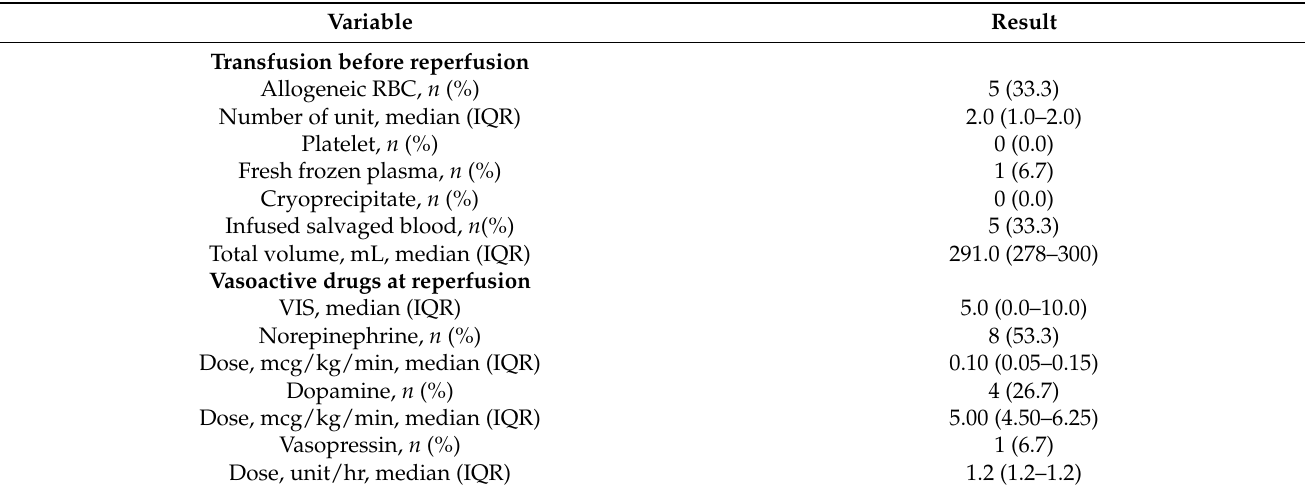
Peak blood potassium after reperfusion showed strong correlations with preoperative blood potassium (Pearson’s r = 0.7, p < 0.004) and blood potassium at T -10 (Pearson’s r = 0.97, p < 0.001) and T 0 (Pearson’s r = 0.95, p < 0.0001). Other perioperative variables did not show a significant correlation with peak blood potassium (Table 3). Hemodynamic parameters and laboratory values measured one hour after the anhepatic phase and at T -10 are presented in Supplementary Table S1. They did not show a significant relationship with peak blood potassium. Changes in the partial pressure of arterial carbon dioxide (PaCO 2 ), pH, bicarbonate, and lactate after reperfusion are presented in Figure 2. After reperfusion, PaCO 2 increased, and pH decreased significantly, and those values did not return to baseline after 5 min. Lactate increased until T 3 and then returned to baseline at T 4 . After reperfusion, mean arterial blood pressure started to decrease at T 2 and returned to its baseline at T 4 (Supplementary Figure S1). Table 3. Correlation analysis of perioperative factors associated with peak blood potassium after reperfusion. Correlation Coefficient